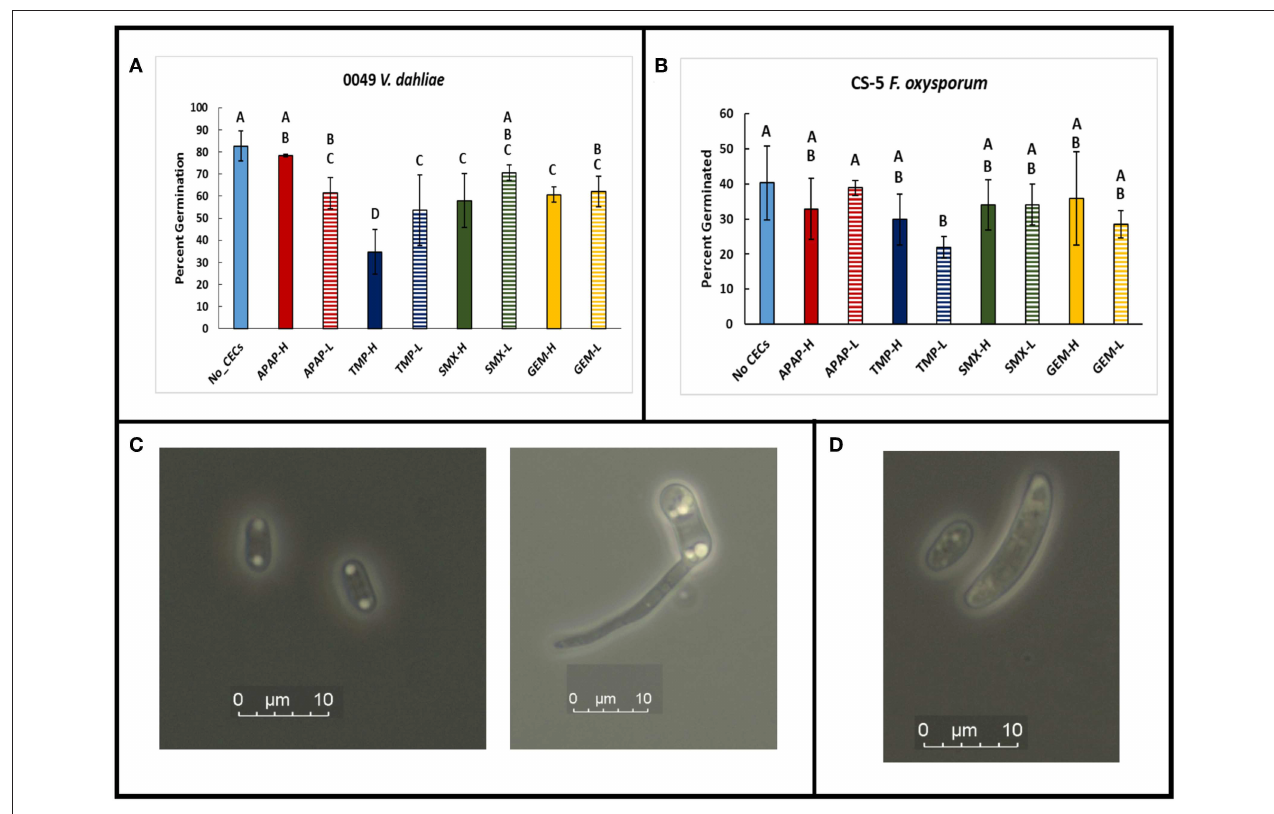
FIGURE 3 | Spore germination assays done in a mild sucrose solution. GLiM with normal distribution and identity link function used for all statistical comparisons. Samples that do not share the same letter are significantly different as determined by a post-hoc , pairwise GLiM analyses done with sequential Bonferroni correction for multiple comparisons (all P ’s < 0.05). (A) Spore germination results for Verticillium dahliae after 12h of incubation in a 0.085M sucrose solution. (B) Spore germination results for Fusarium oxysporum f.sp lycopersici after 12h of incubation in 0.085M sucrose solution. (C) Photographs of Verticillium dahliae spores at 1,000 × total magnification. Ungerminated spore (left), germinating spore (right) (D) Photograph of small and large Fusarium oxysporum f.sp lycopersici spores at 1,000 ×